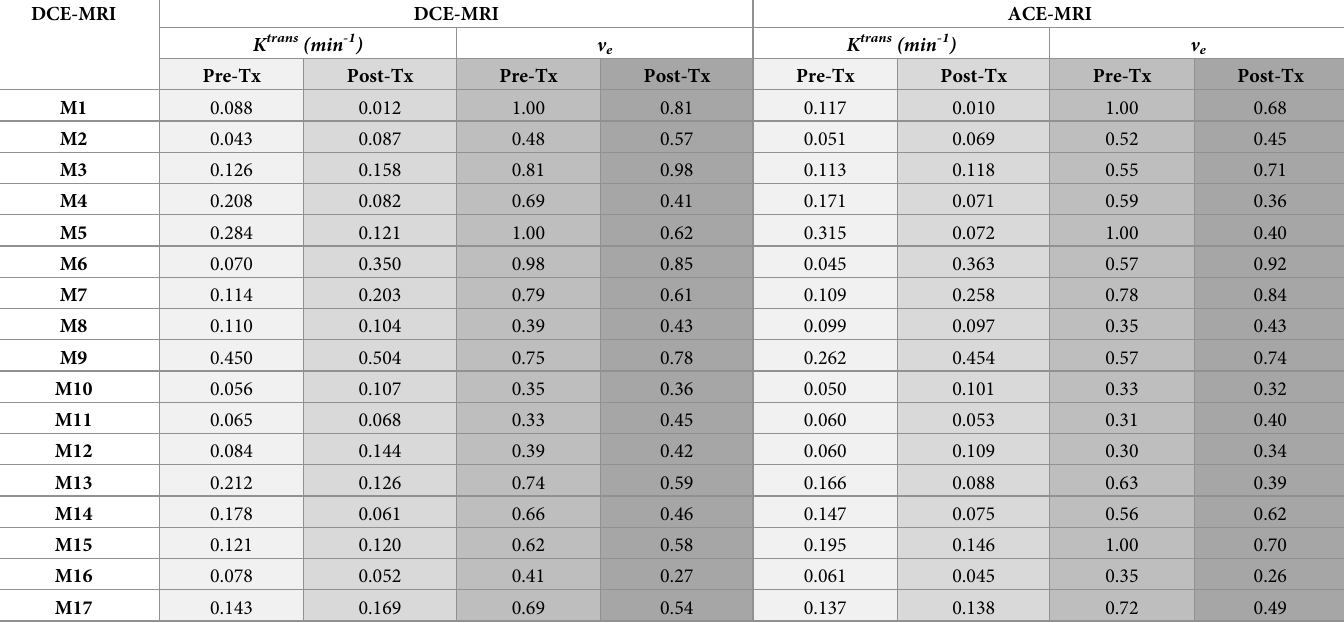
Table 1. List of median K trans and v e values for all the tumors obtained with DCE-MRI and ACE-MRI. DCE-MRI DCE-MRI